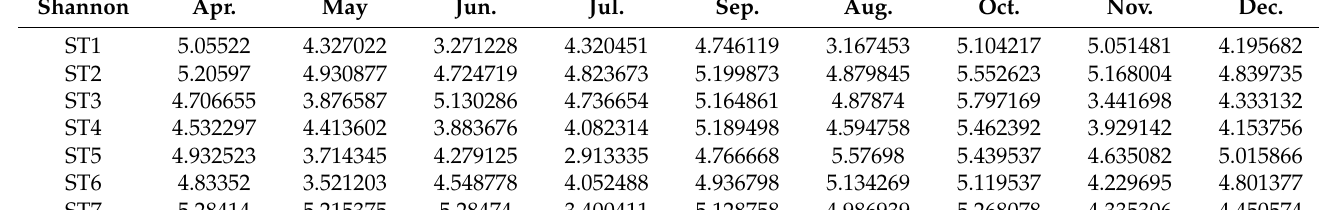
Table 3. Alpha diversity analysis of the bacterioplankton community in Qingcaosha Reservoir. Shannon